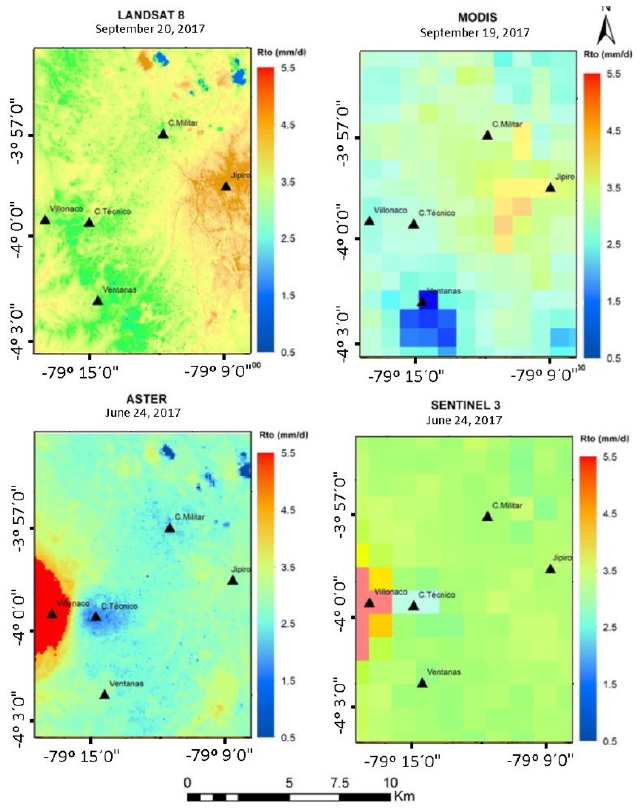
Figure 5. Maps of ETo (mm day − 1 ) for the different satellite products.